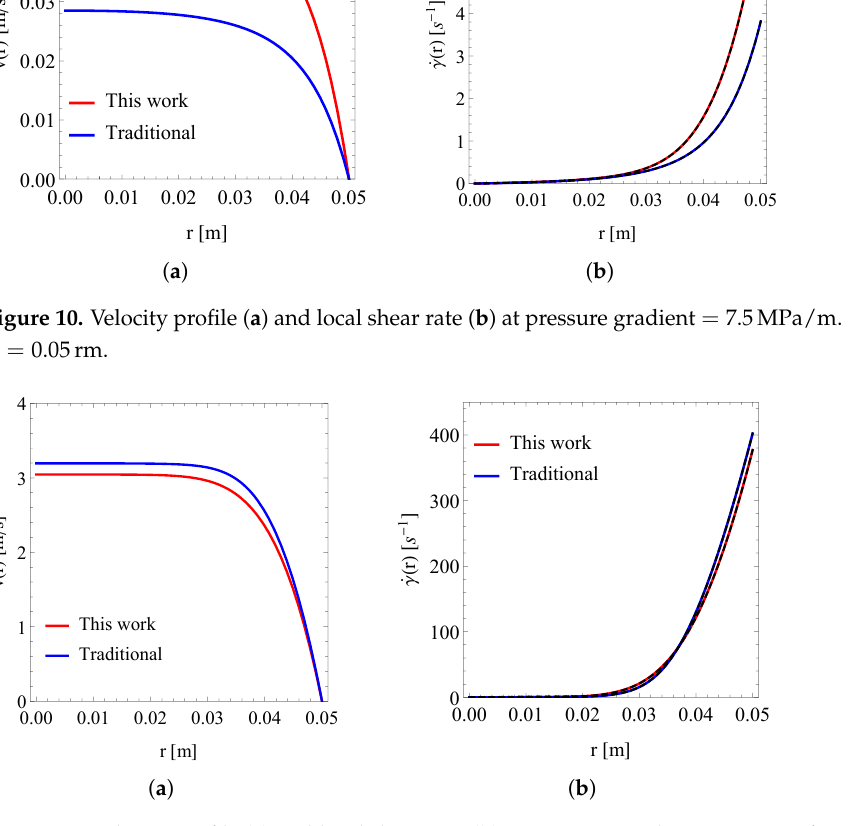
Figure 11. Velocity profile ( a ) and local shear rate ( b ) at pressure gradient = 15MPa/m. Tube radius R =